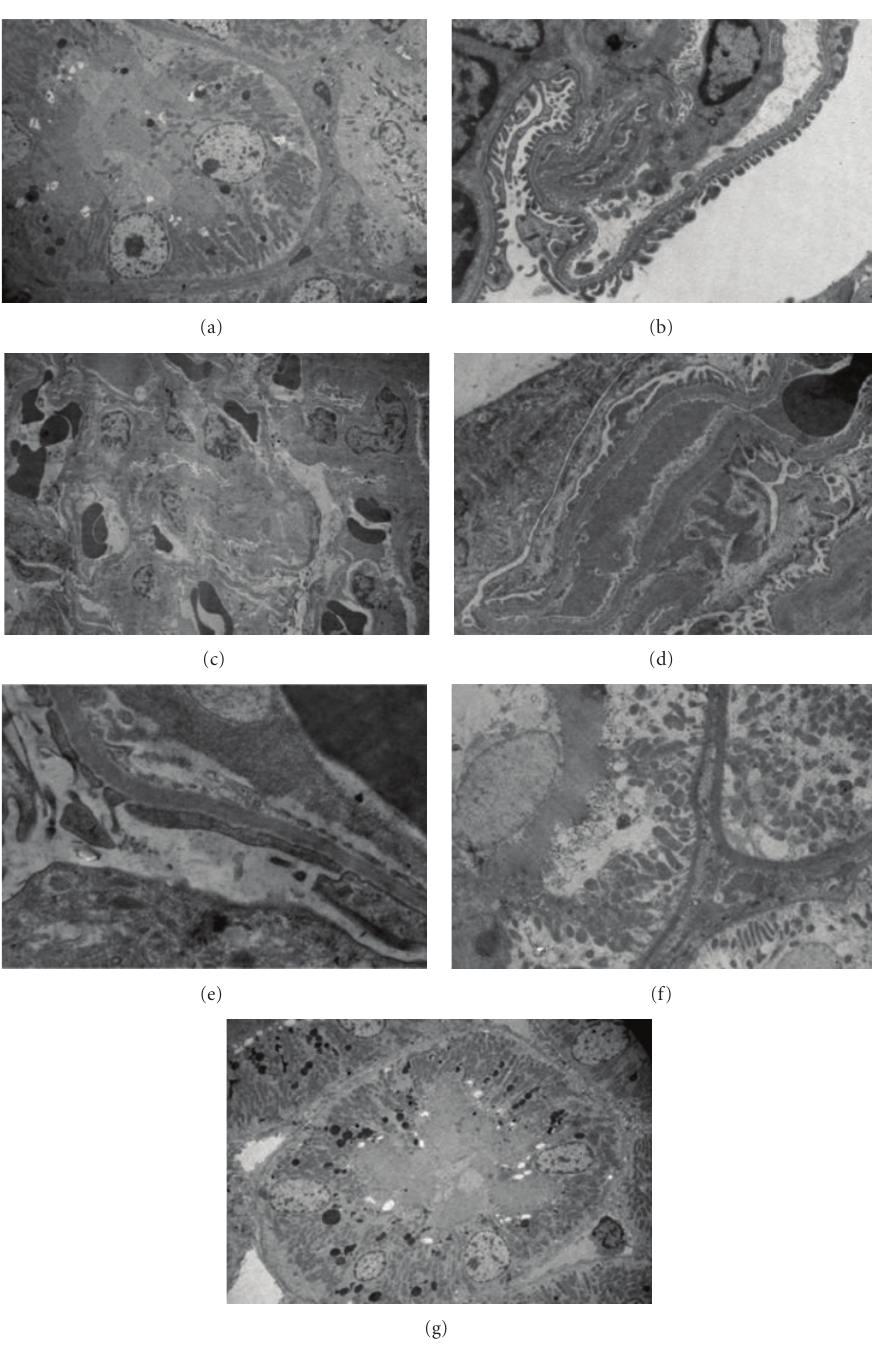
Figure 4: (a) and (b) Control × 3000 and nicotinamide (NAD) × 10 K; doxorubicin (DXR), (c) × 3000, (d) × 10k, (e) × 30 K, (f) × 5000, DXR+NAD, (g) ×